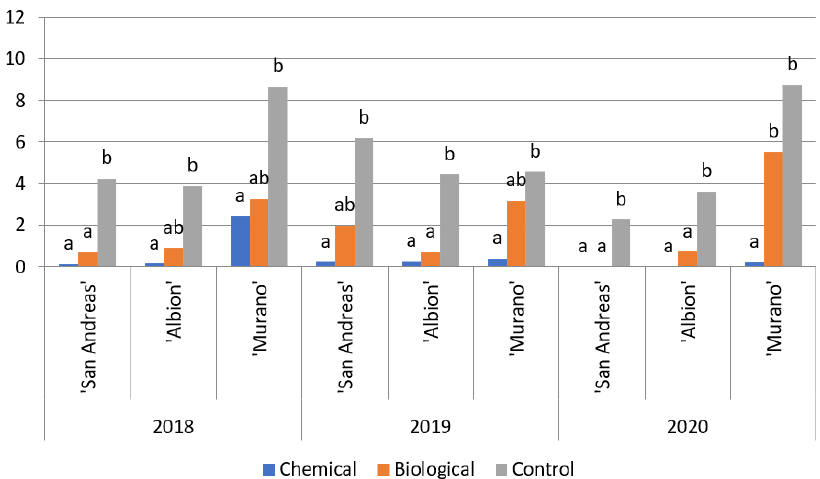
Figure 6. Percentage of fruit infected by fungus-like organisms of the genus Phytophthora among fruit waste at harvest [%]. Bars on which the same letter follows within a cultivar for each year are not significantly different at p ≤ 0.05.